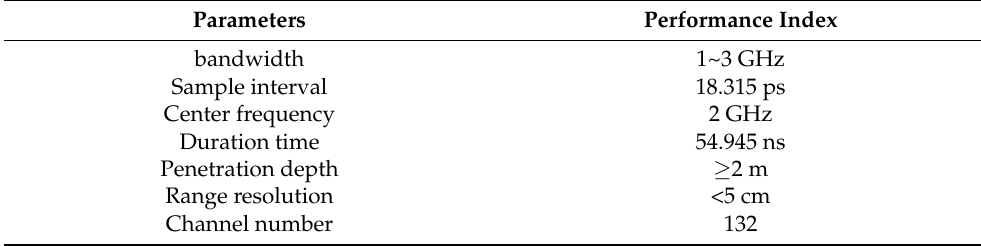
Figure 2. The layout of LRPR antennas. The interval between adjacent antennas is 0.12 m, and the width of the synthetic aperture is 1.56 m. Table 1. Main Parameters of